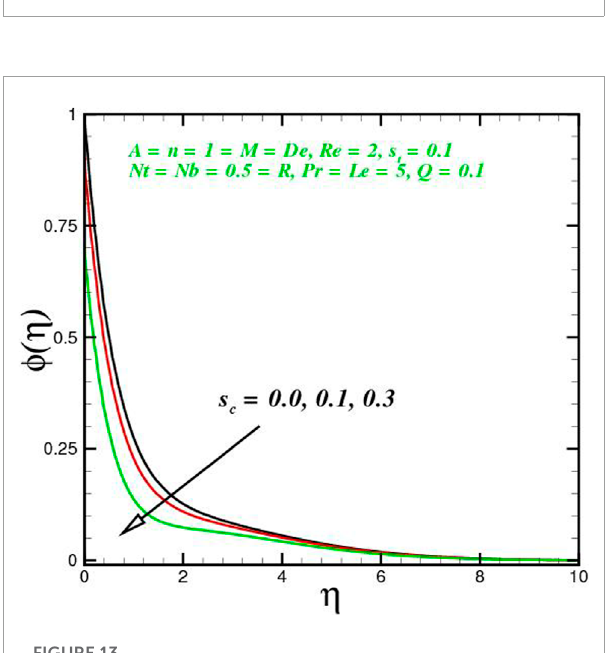
FIGURE 13 ϕ ( η ) ), alteration via S c